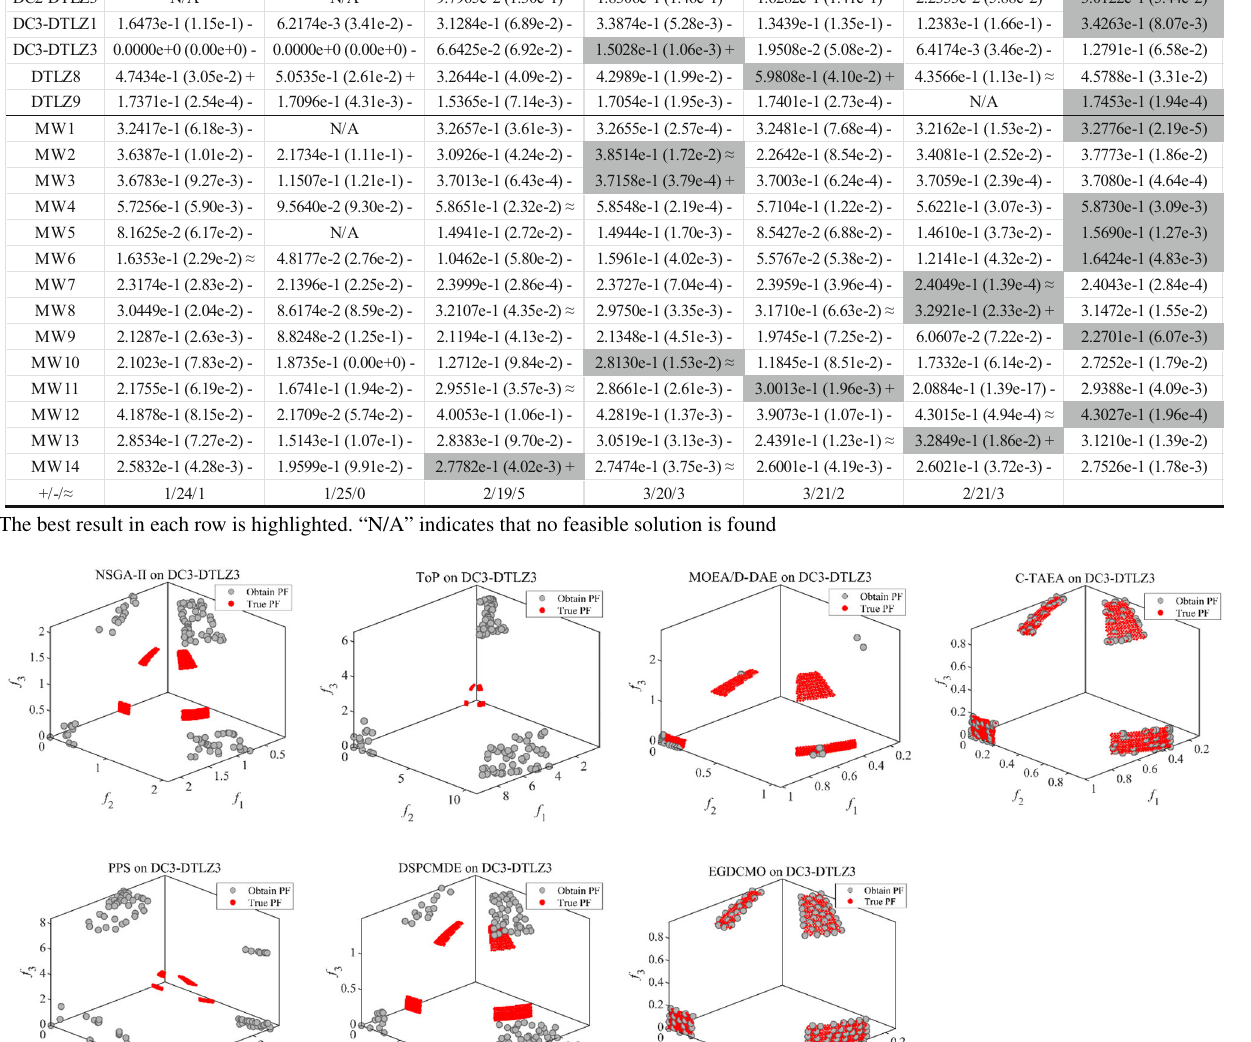
Fig. 11 Pareto front with median IGD value obtained by the proposed EGDCMO and all the compared CMOEAs on DC3-DTLZ3